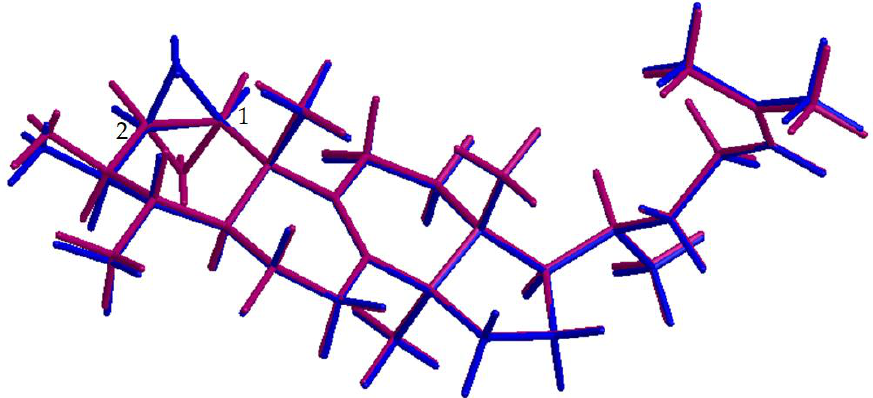
Figure 12. 3D model of 29-nor-1 β ,2 β - cis -epoxy-lanost-8,24-diene-3 β -triol (blue) and 29-nor-1 α 2 α - cis -epoxy-lanost-8,24-diene-3 β -triol (violet). Compound 30 (2.0 mg) was obtained as white crystals and assigned a molecular formula of C 32 H 52 O 3 by HRLIFDIMS ( m / z 484.3900 M + , calc. for 484.3911). The NMR data elu-